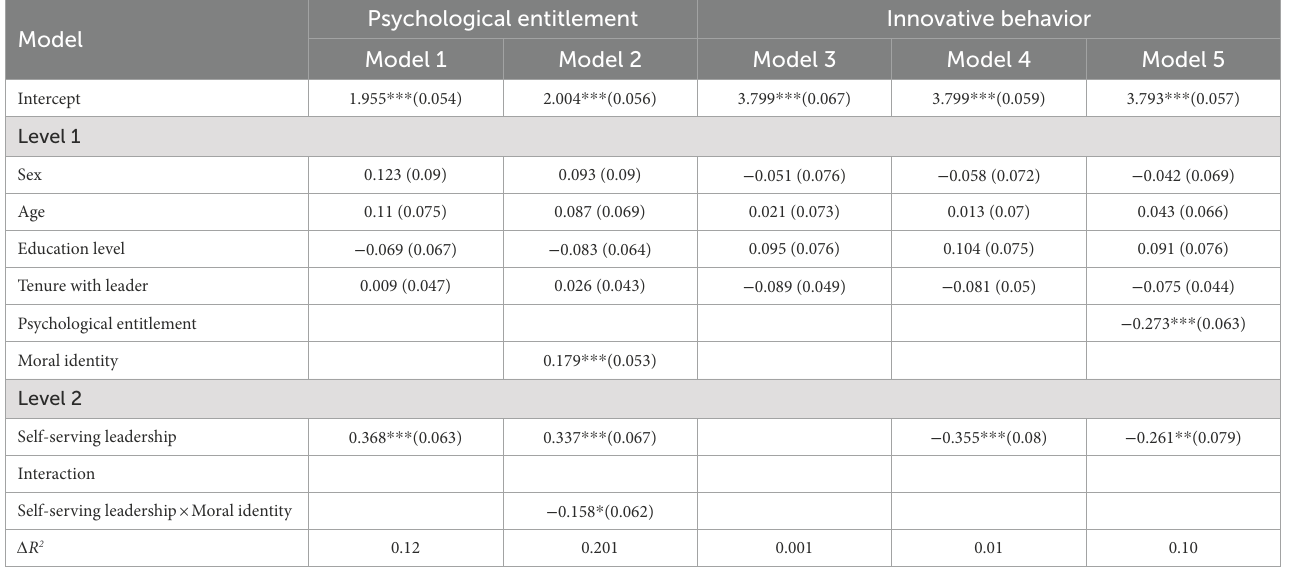
TABLE 4 Results of hierarchical linear